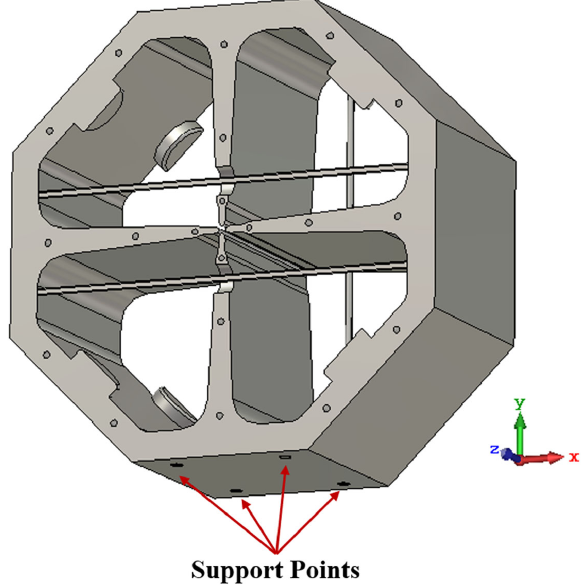
FIG. 24. RFQ module with a length of one PISL period.